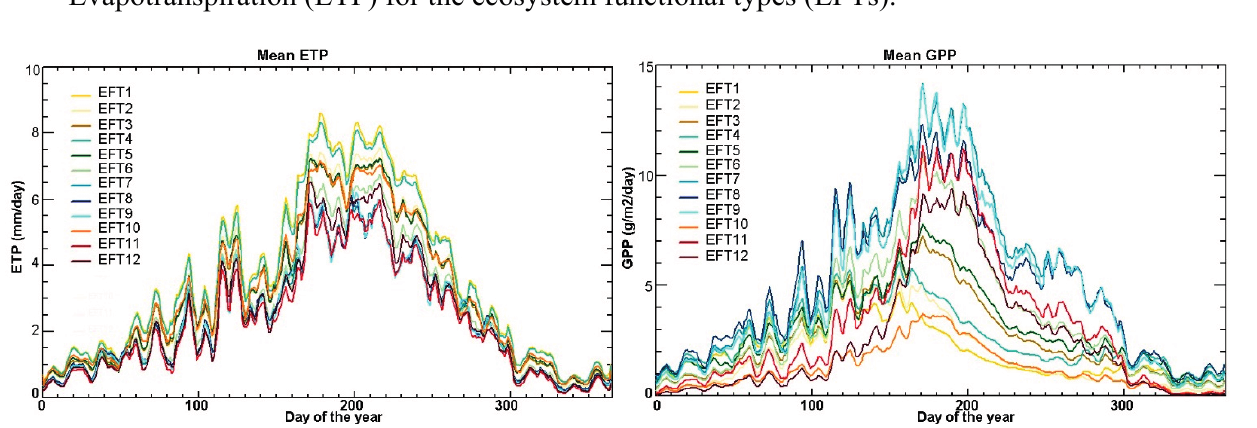
Figure 9. Mean seasonal profile of the Gross Primary Production (GPP) and the rate of Evapotranspiration (ETP) for the ecosystem functional types